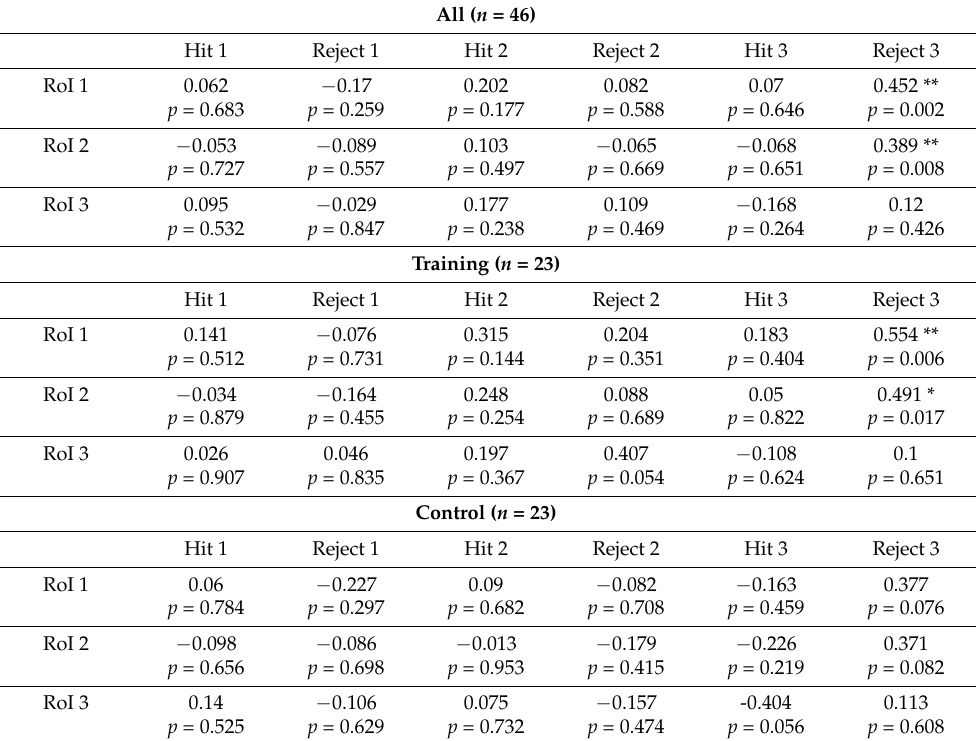
Table 4. Spearman’s correlation coefficients between brain activations in contrast 3 (‘Correct vs. Incorrect’) and two measures of accuracy in the N-back task: the number properly detected targets (Hit) and the number of correct rejections